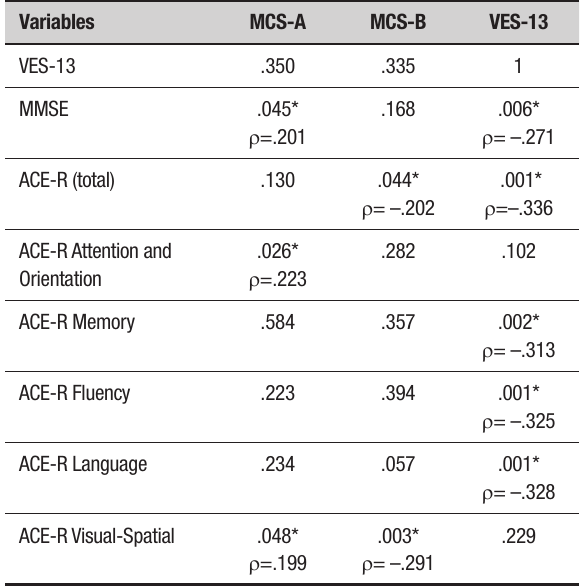
Table 4. Results of correlations with Spearman’s test. Brazil,